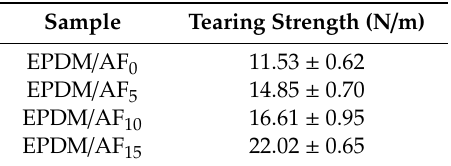
Table 5. Mechanical properties of ceramifiable EPDM